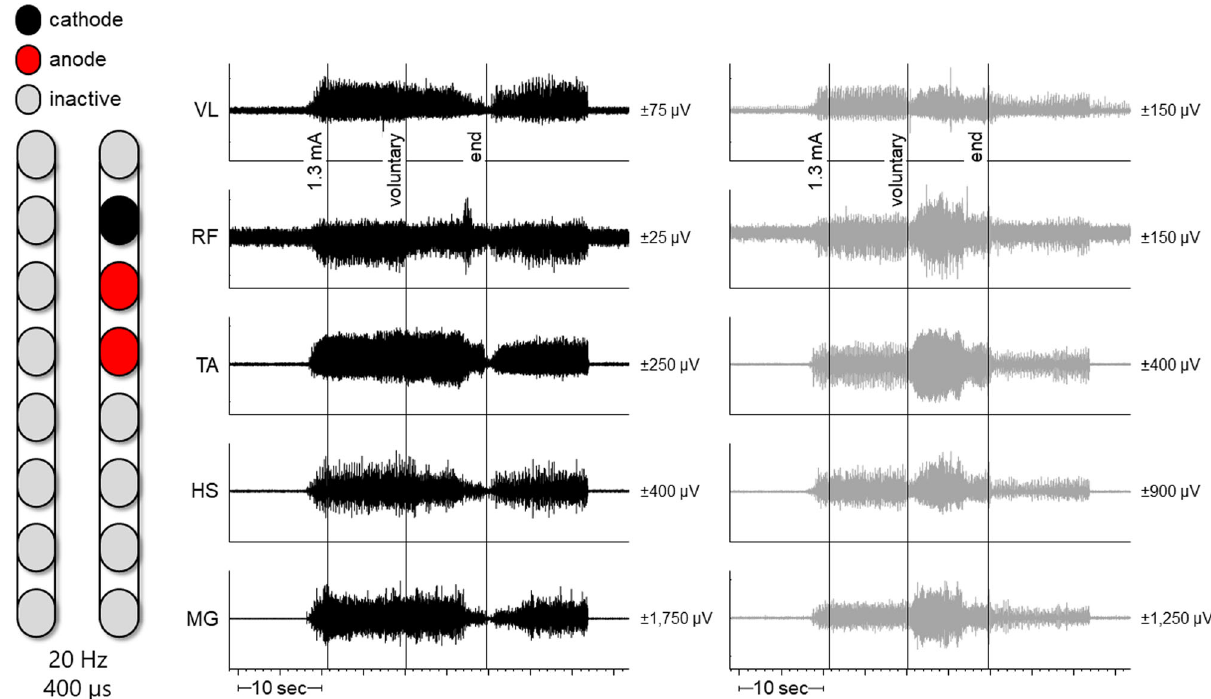
Fig. 3 | Con fi gurationfor 0773 resulting in right leg fl exion. Leftlegmusclesare depictedinblackandrightlegmusclesingray.Bothplotsoccurredsimultaneously but have been separated to better visualize different effects of voluntary effort between legs. At 1.3mA, bilateral muscle activity was induced. However, when the participant volitionally attempted to fl exhisright leg,muscle activity decreasedin